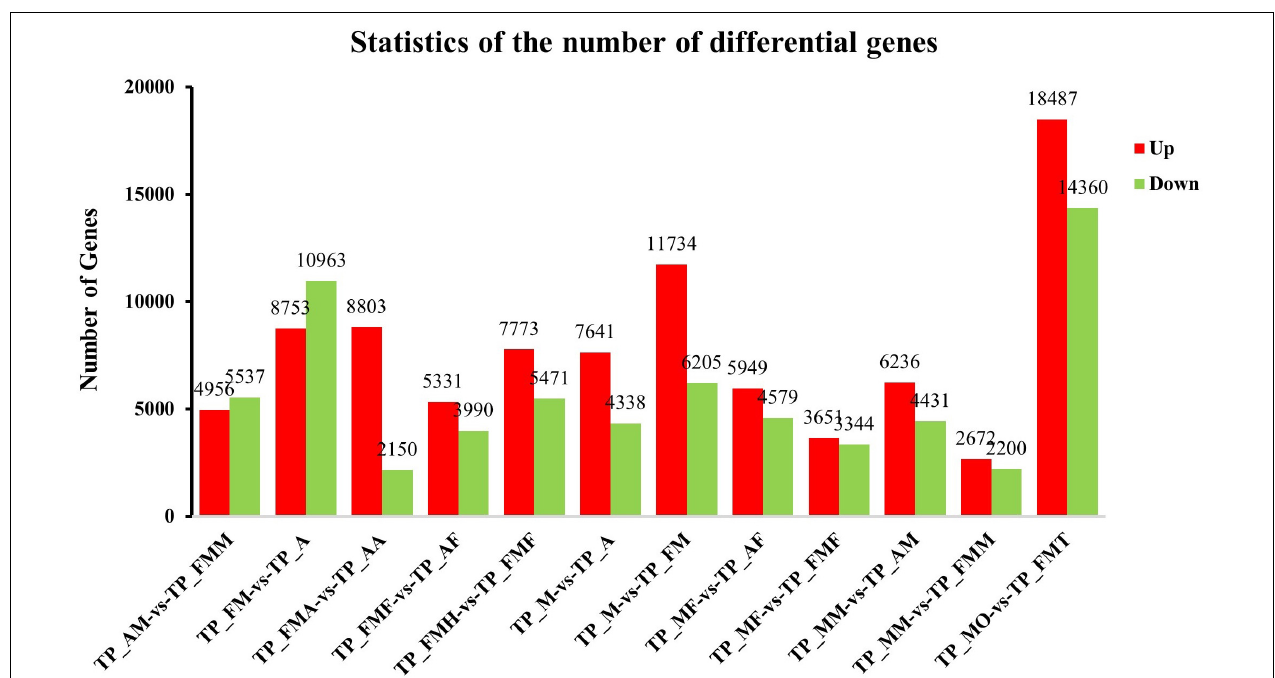
FIGURE 4 | Analysis of differentially expressed genes (DEGs) at different development stage. The X axis represents the difference comparison scheme for each group, and the Y axis represents the corresponding DEG number. Red represents the number of DEGs that are up-regulated, and blue represents the number of DEGs that are